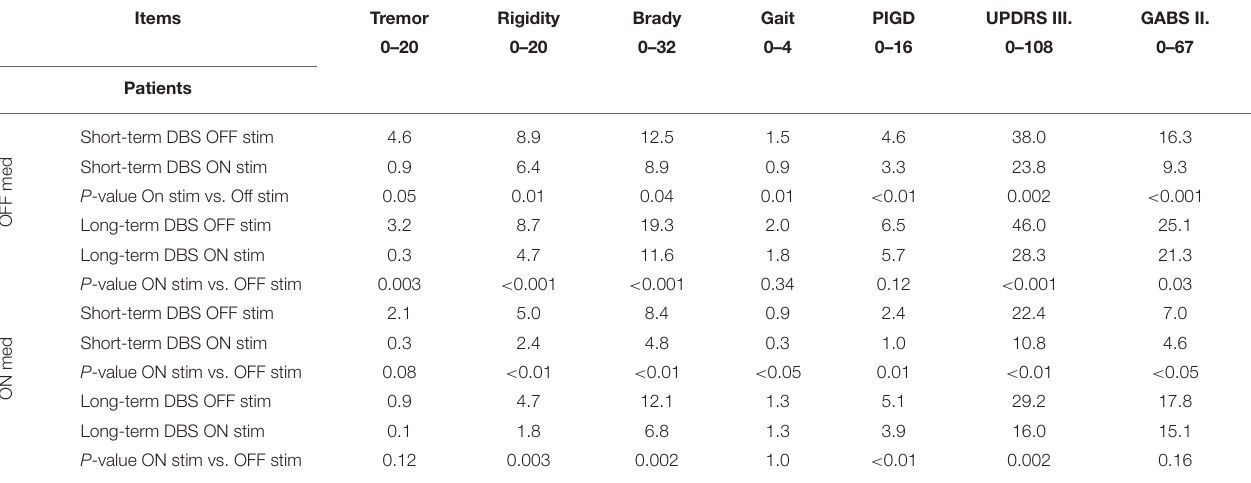
TABLE 1 | The mean values of UPDRS III and GABS II in all four states (stim/med) in patients with short and long-term stimulation ( P -value). Items